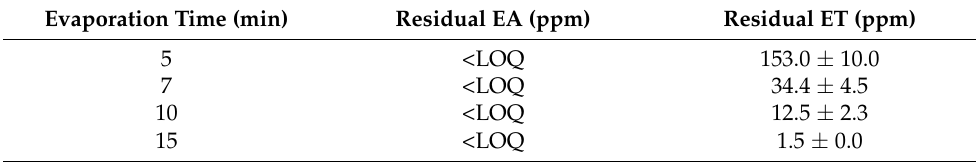
Table 5. Residual solvents after evaporation at 40 ◦